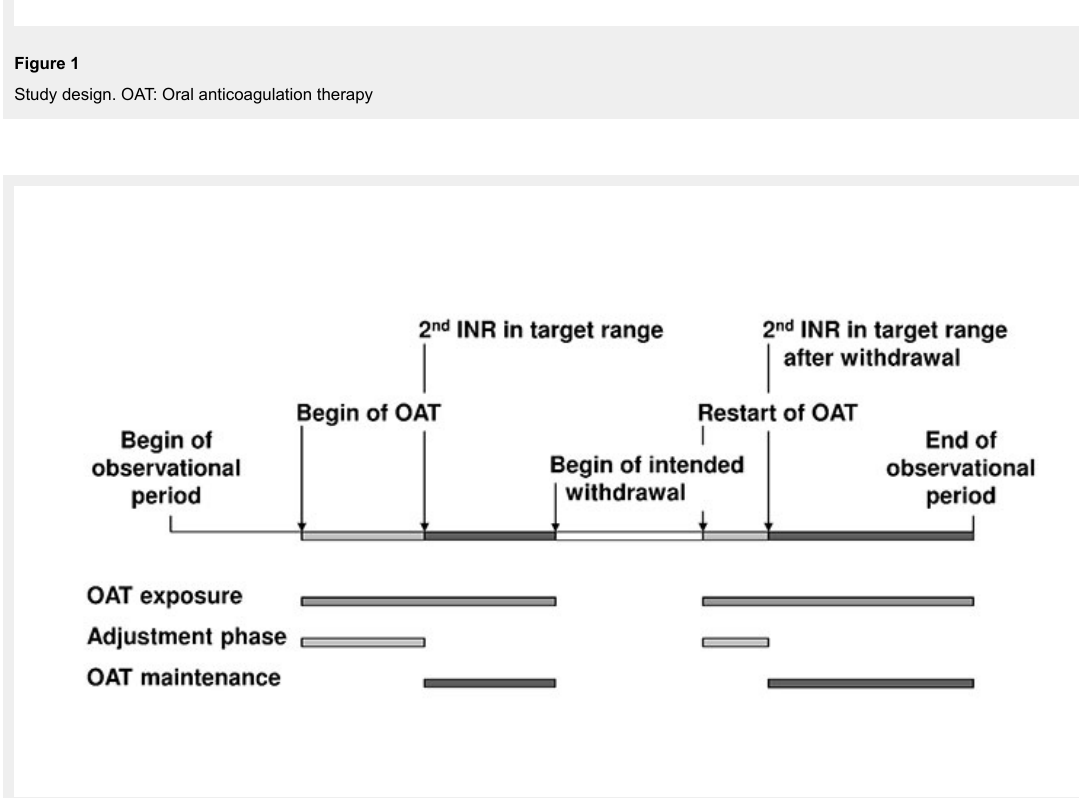
Figure 2 Definition of oral anticoagulation therapy (OAT) exposure, adjustment phases and OAT maintenance. OAT: oral anticoagulation therapy. OAT exposure: time from the first dose of OAT to the end of OAT (temporary or definitive). Adjustment phase: time from first INR at start/restart of OAT to the 2nd INR value within target range. Intended withdrawal: time of temporary suspension of OAT (e.g., for scheduled surgery). OAT maintenance: time from 2nd INR value in target range after start/restart to end of OAT (temporary or